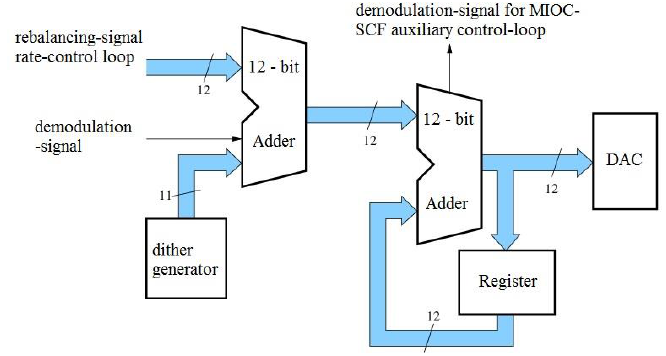
Figure 14. Modulation stage and phase accumulator used in the current design.